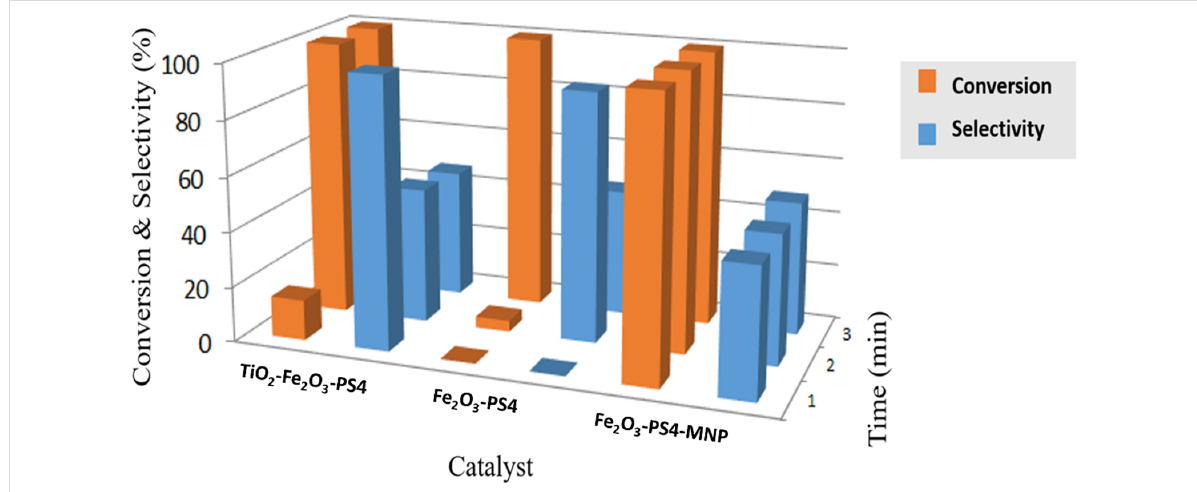
Figure 6: Conversion and selectivity of the microwave-assisted alkylation of toluene for the three catalytic systems.